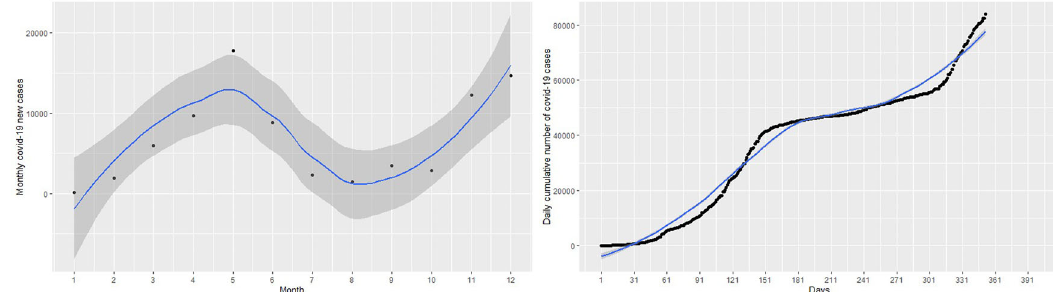
Figure 1. Plots of monthly new coronavirus disease 2019 (COVID-19) cases (left panel) and daily cumulative cases (right panel) from March 14, 2020 to February 28,